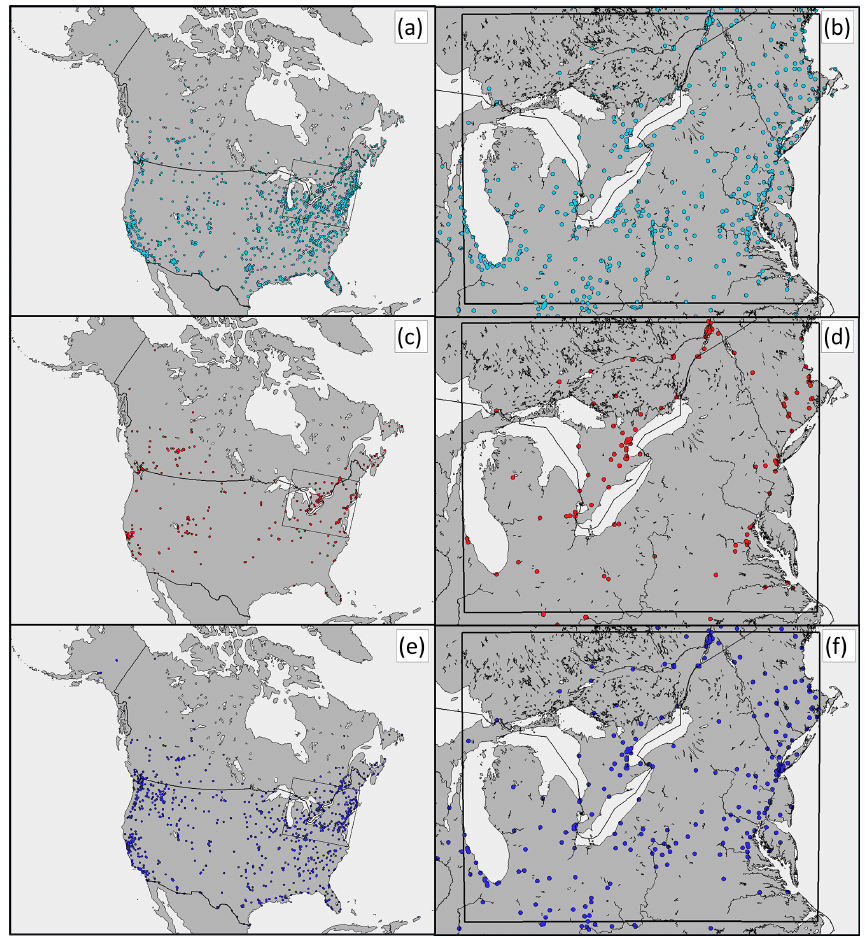
Figure 6. AQS and NAPS hourly observation station locations for ozone (a, b) , nitrogen dioxide (c, d) , and particulate matter with diameters less than 2.5µm (e, f) . (a, c, e) Stations used for the 10km grid cell size domain evaluation. (b, d, f) Stations used for the 2.5km grid cell size domain evaluation (all stations located within central